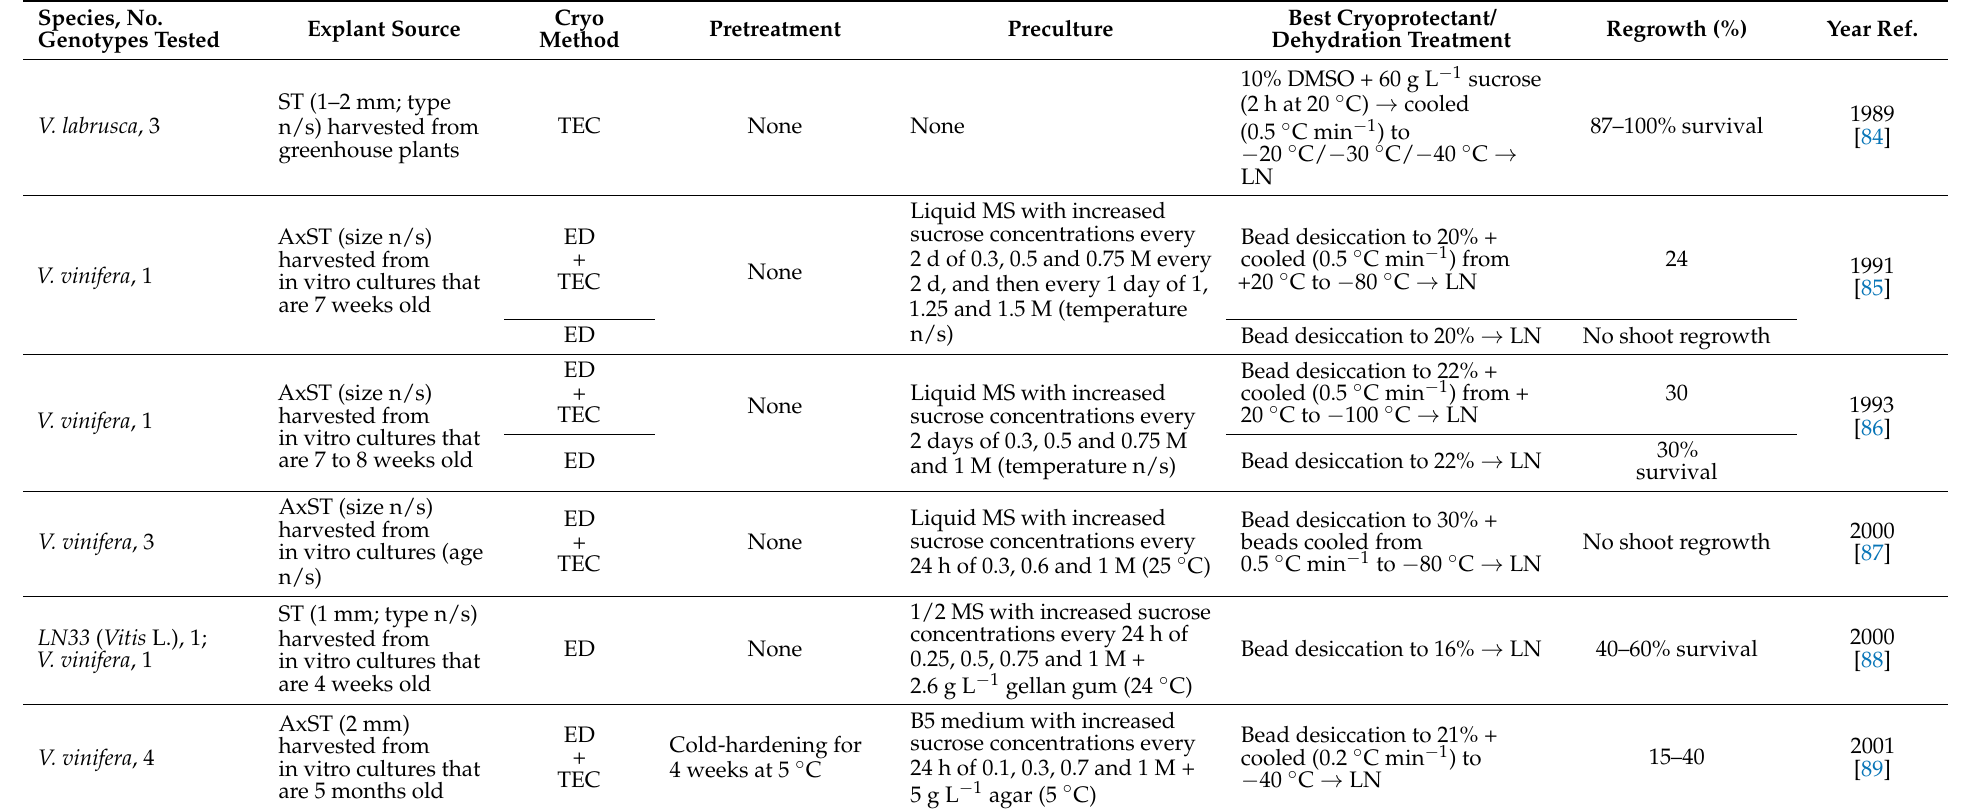
Table 1. List of research reported from 1989 to 2021 on grapevine shoot tip